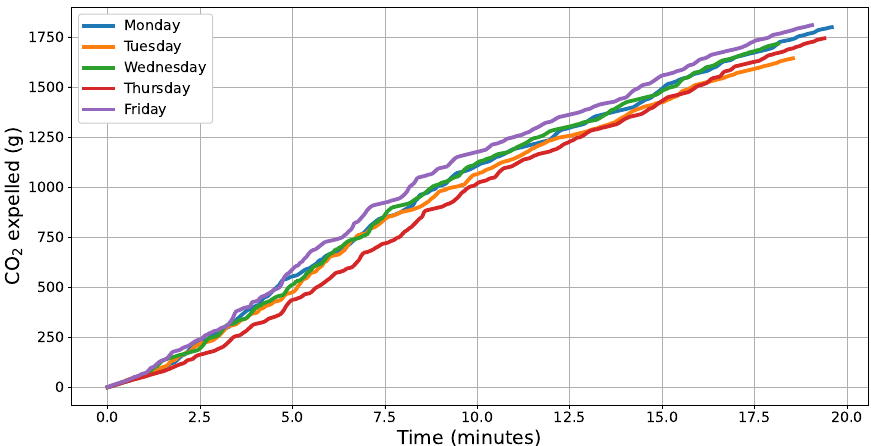
Figure 4. CO 2 (g) expelled along the trip for each day of the